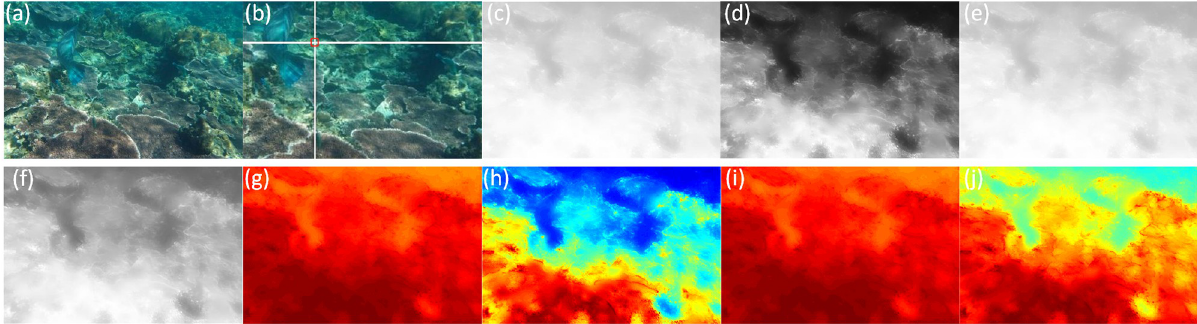
Fig 6. Image transmission. (a) Original; (b) Background light; (c) Backscatter component transmission; (d) R channel direct component transmission; (e) G channel direct component transmission; (f) B channel direct component transmission; (g) Thermodynamic diagram of figure (c); (h) Thermodynamic diagram of figure (d); (i) Thermodynamic diagram of figure (e); (j) Thermodynamic diagram of figure